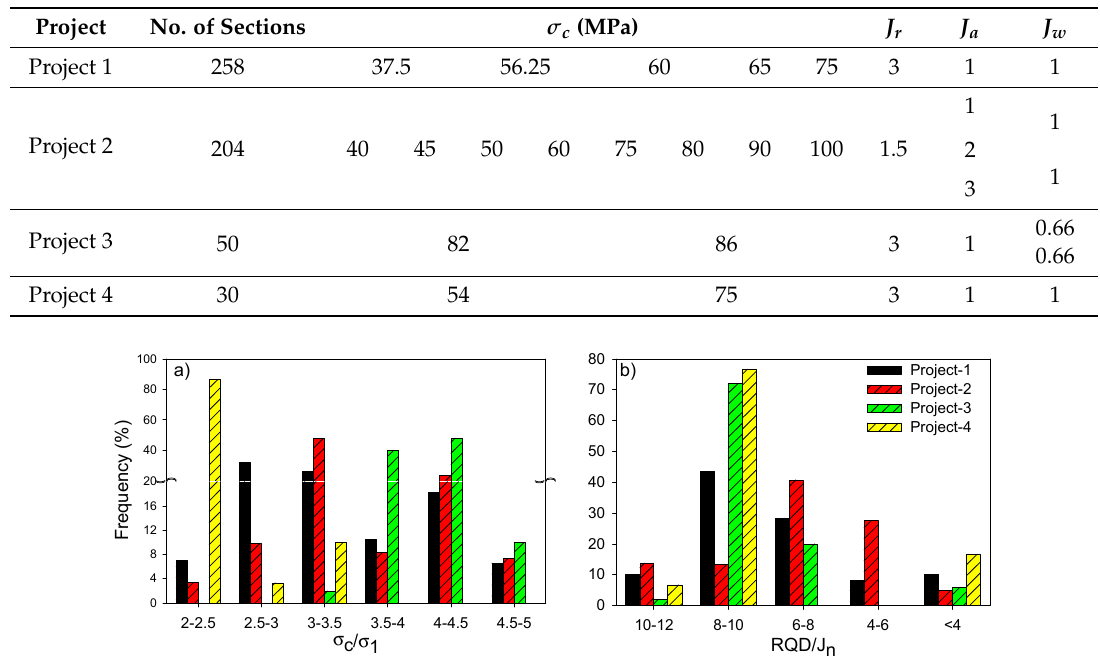
Figure 2. Percentage frequency of ( a ) intact rock strength ( σ c ) to major principal stress ( σ 1) ratio ( σ c / σ 1 ); ( b ) relative block size ( RQD / J n ) for the first four tunnel projects.